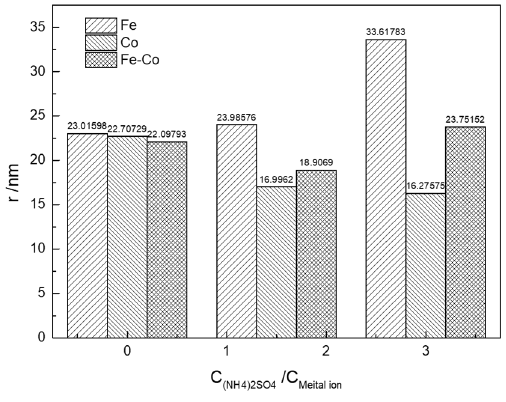
Figure 13. Crystallite size with different (NH 4 ) 2 SO 4 concentrations.